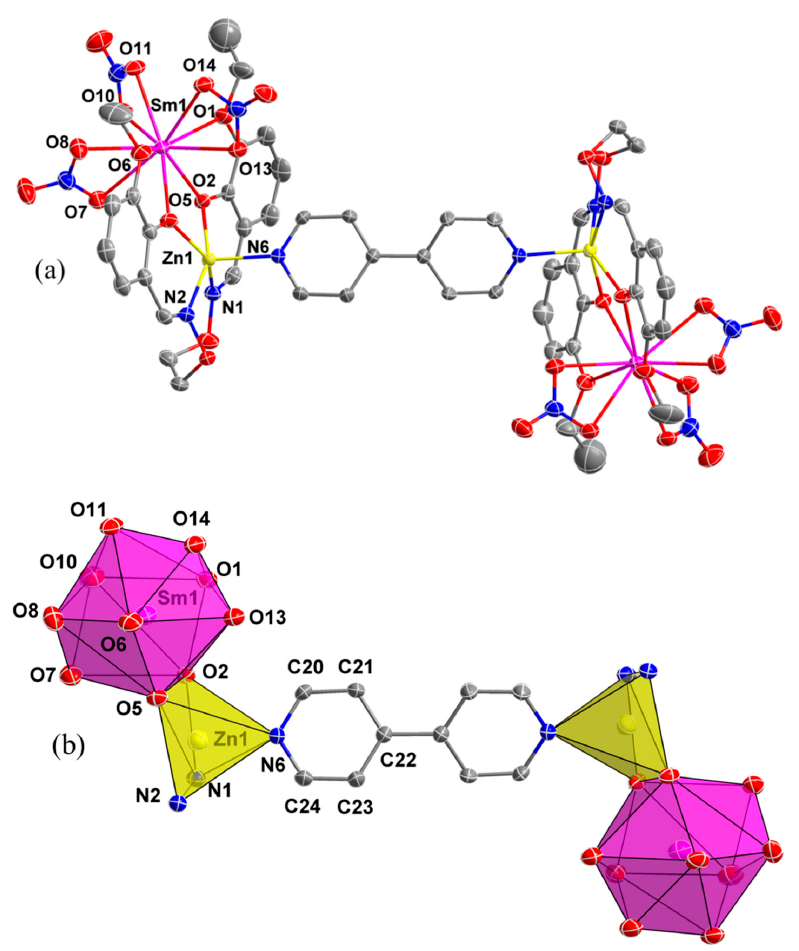
Figure 3. ( a ) Crystal structure diagram of the [Zn II2 –Sm III2 ] complex (30% probability displacement ellipsoids, a hydrogen atom, and two free methanol molecules are omitted for clarity), ( b ) Coordination pattern diagram of Zn II /Sm III ions and 4,4 ′